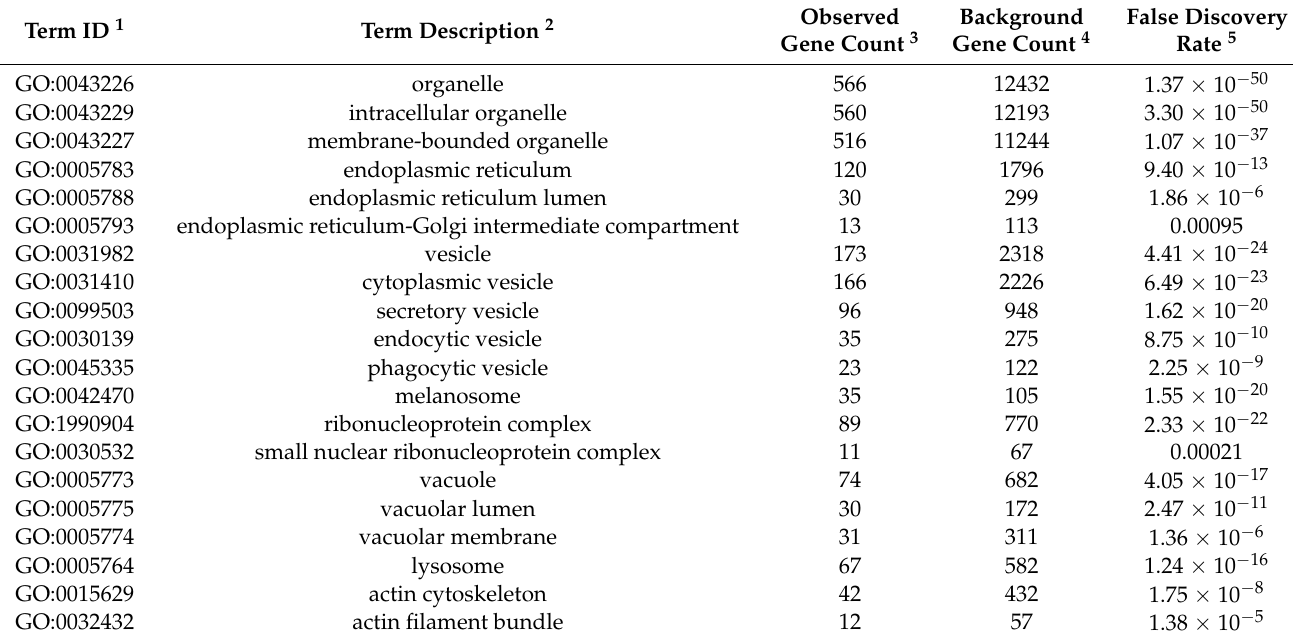
Table 3. Selected cellular components altered in HF-MSS, based on Gene Ontology enrichment